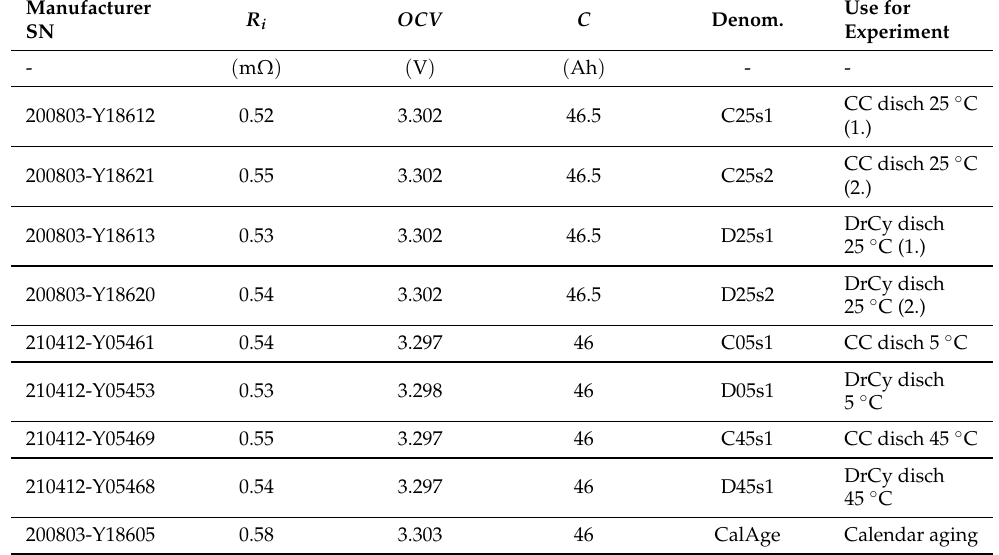
Table 3. Use of samples for the experiment.